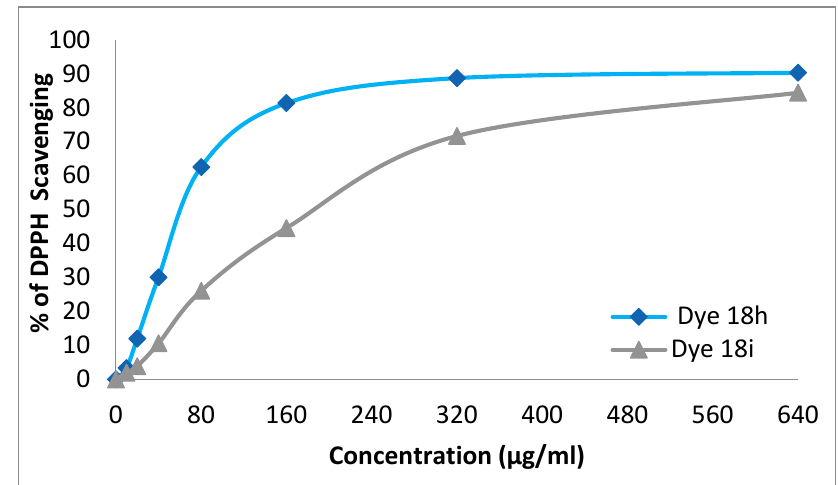
Figure 5. Antioxidant activities of disperse dyes 18h and 18i.